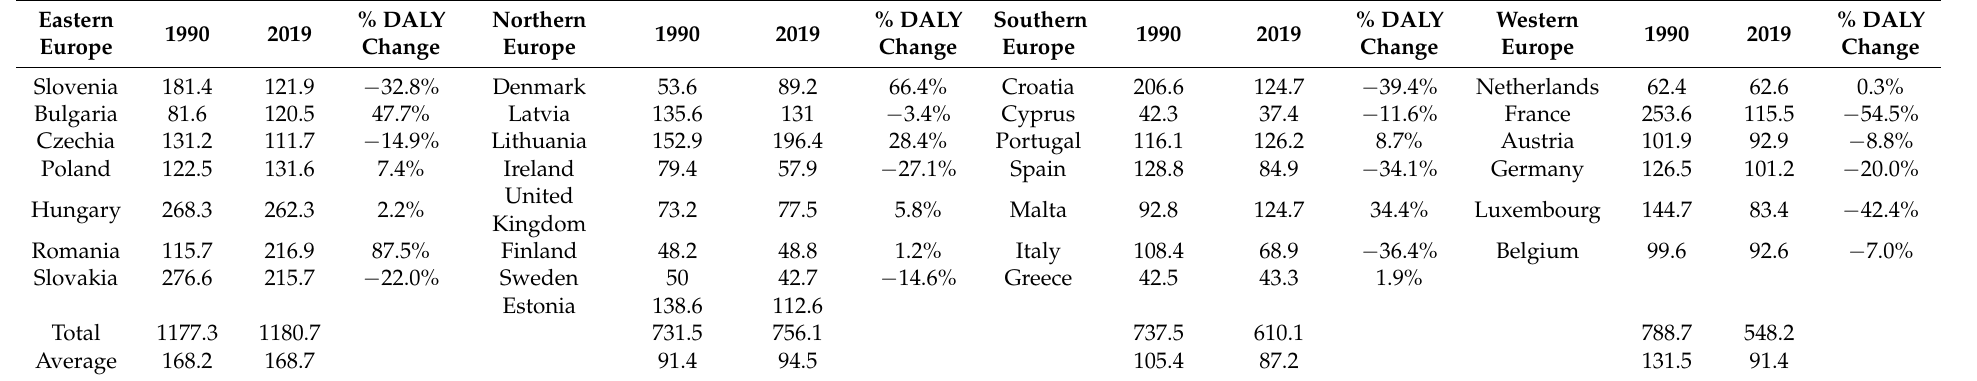
Table 2. Age-standardised DALYs per 100,000 in 1990 and 2019, with EAPC, countries displayed according to UN European